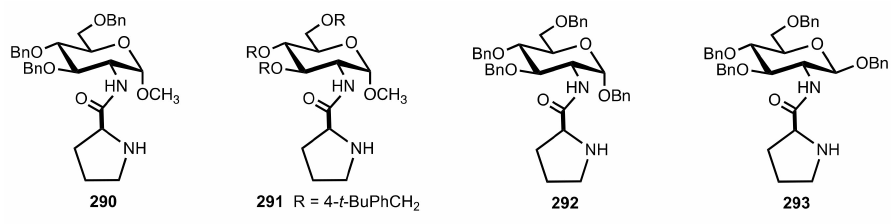
Figure 24. Sugar prolinamide organocatalysts prepared by Agarwal and